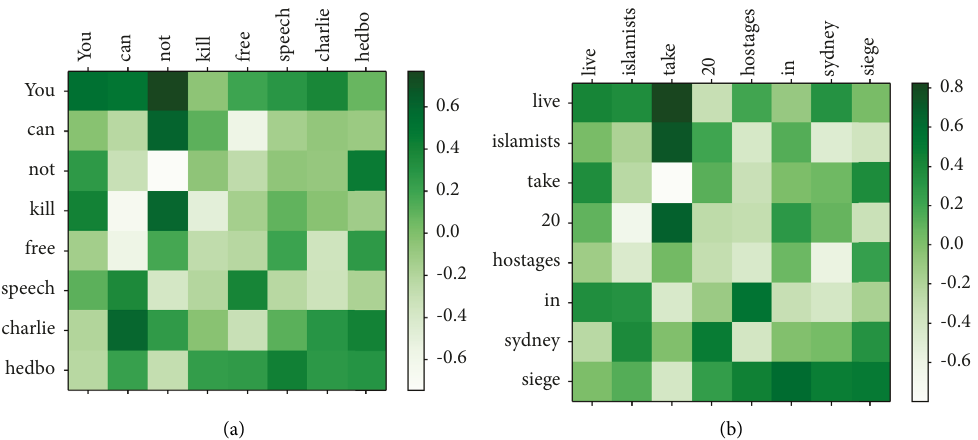
Figure 7: Case Study: a testing example demonstrates that the information of dependency tree contributes to the classification performance; our model generated a proper attention distribution with the assistance of dependency tree. Darker cell color indicates higher attention value.(a) The attention matrix of nonrumor by our method. (b) The attention matrix of rumor by our